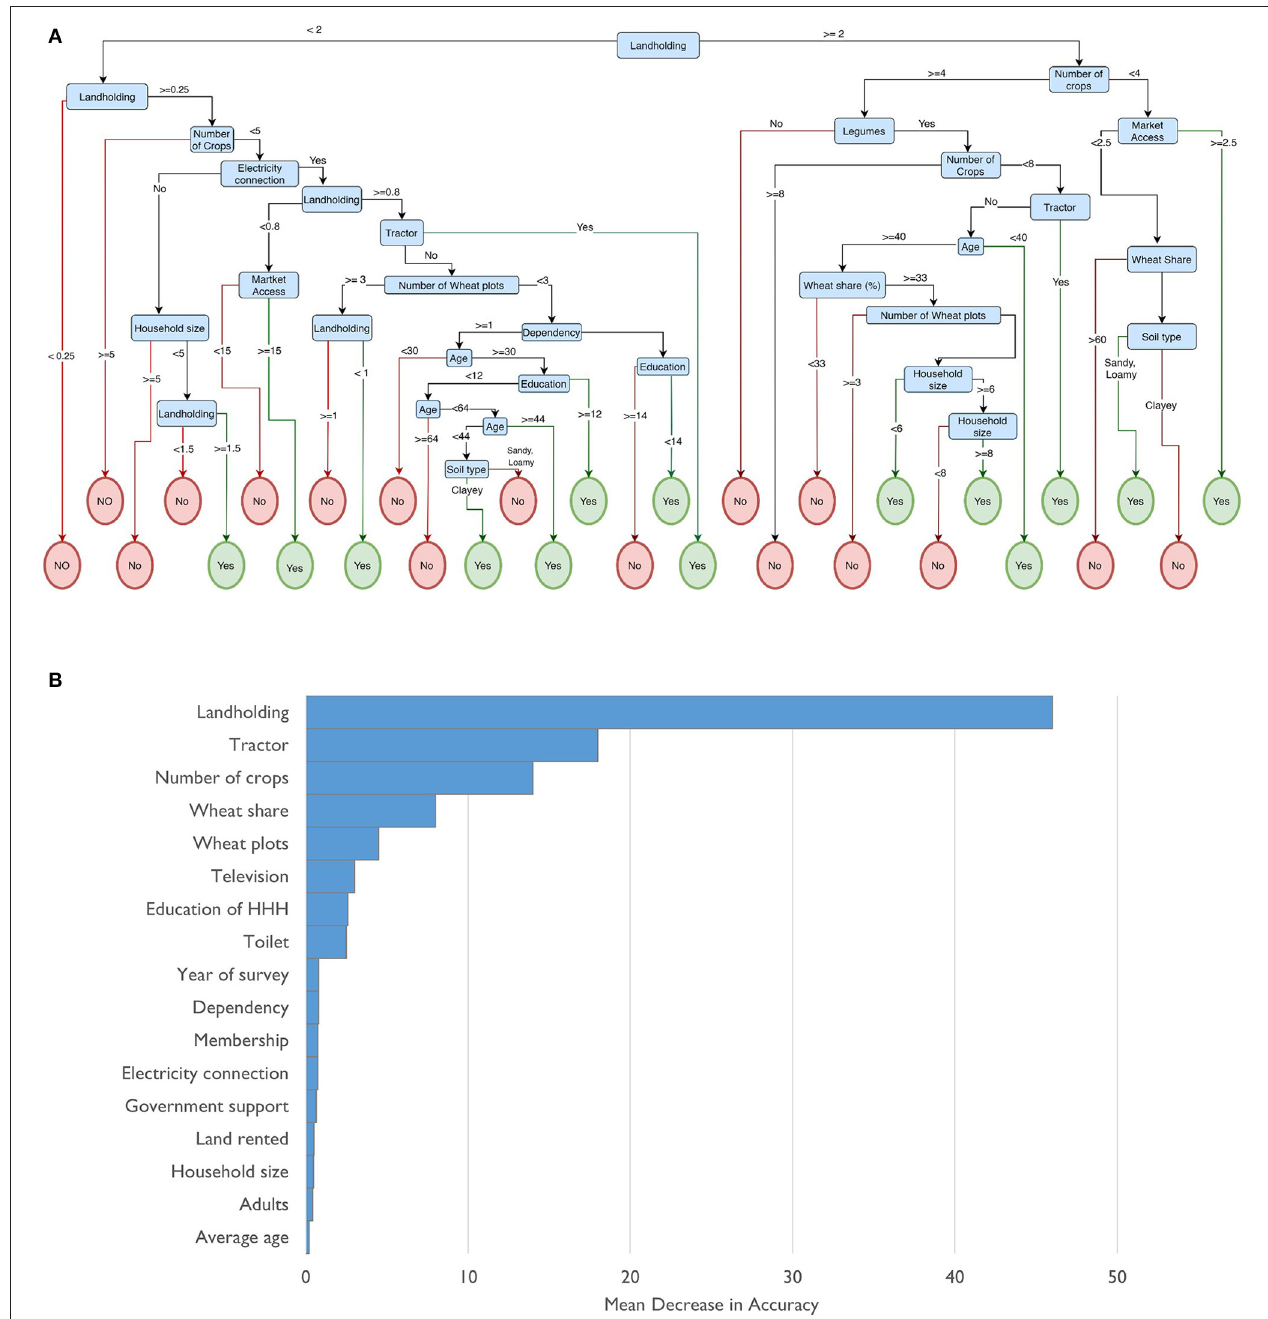
FIGURE 3 | (A) CART on Farmer Adoption of Zero Tillage in Bihar. The variables are defined, and summary statistics provided in Supplementary Materials S1(b) . (B) Importance of predictor variables in the Random Forest Models on ZT adoption in Bihar. The variables are defined in Supplementary Materials S1(b) .